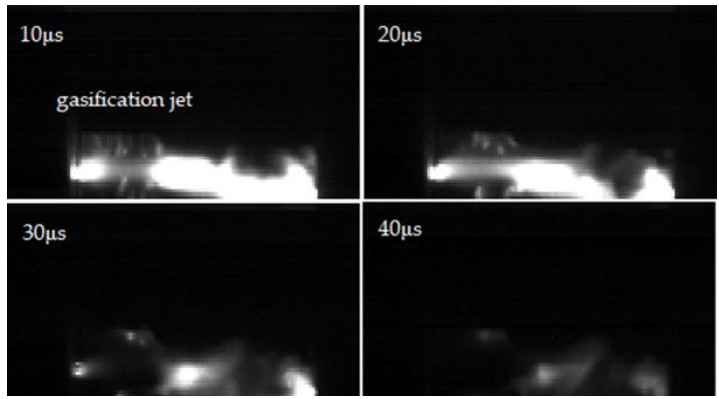
Figure 11. Material gasification during